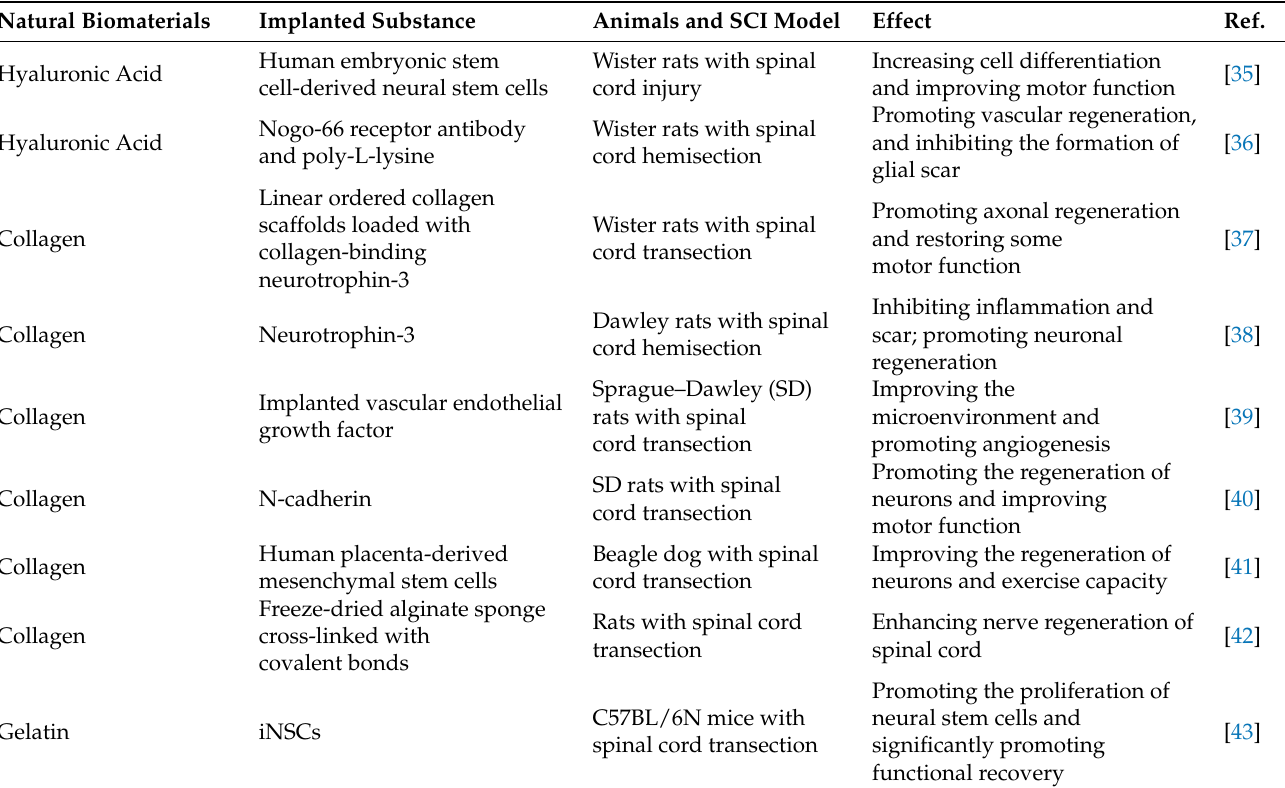
Table 1. The bioactivity of natural biomaterials in various models of SCI.